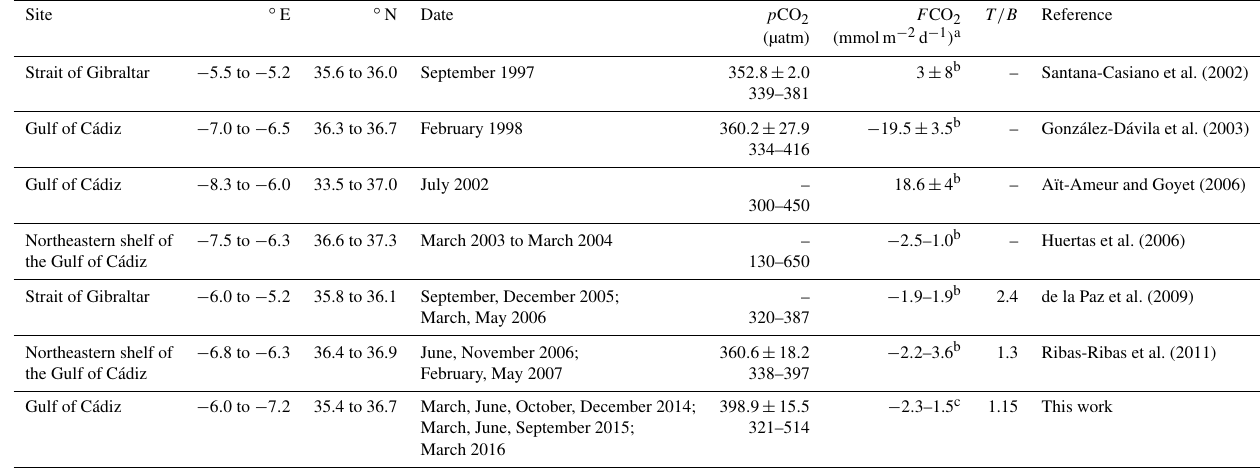
Table 4. Range, mean and standard deviation of p CO 2 , air–sea CO 2 fluxes ( F CO 2 ) and T/B ratio found in different areas of the Gulf of